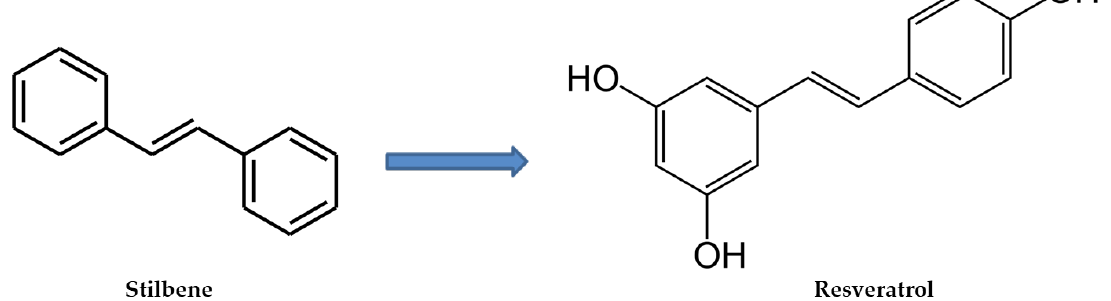
Figure 3. Structures of stilbene and resveratrol.